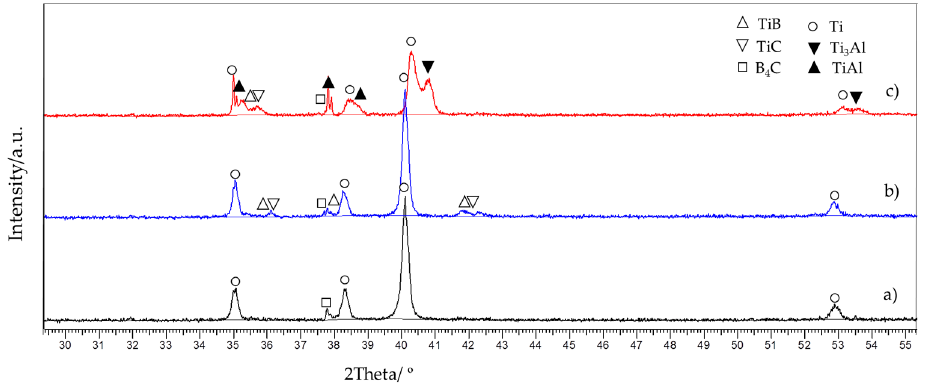
Figure 2. XRD (X-ray diffraction) patterns of the in-situ TMCs (titanium matrix composites) with 30 vol % of B 4 C produced at: ( a ) 900 °C; ( b ) 1000 °C; and; ( c ) 1000 °C with 20 vol % Ti-Al.